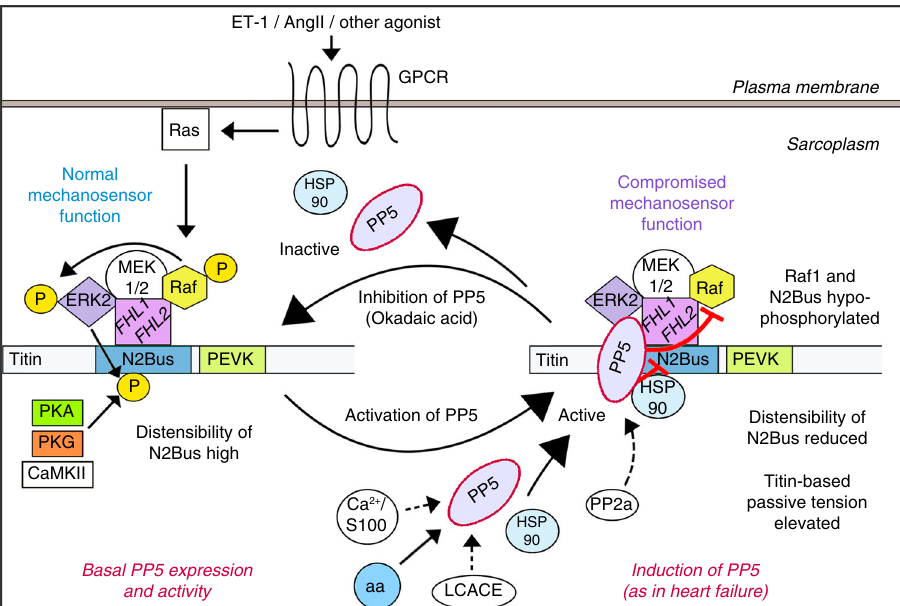
Fig. 8 Proposed actions of PP5 in cardiomyocytes. Under basal conditions, PP5 activity towards titin N2Bus and MAPK/ERK family member Raf1 is low and the relatively high distensibility of N2Bus results in relatively low titin-based passive tension (left side). The strain-dependent mechanosensor connecting MAPKs to N2Bus via FHL-1 functions normally, as downstream signaling from Raf1 to ERK2 is enabled. When PP5 expression is increased (as in failing hearts) and PP5 becomes activated through interaction with Hsp90, Ca 2+ /S100 protein, arachidonic acid (aa), or long chain fatty acid-CoA esters (LCACE), the phosphatase translocates to the I-band mechanosensor at N2Bus (right side). Thus, N2Bus (previously phosphorylated by ERK2, PKA, PKG, or CaMKII) is dephosphorylated, which reduces its distensibility and increases titin-based passive tension; the mechanosensor is now less sensitive. Raf-1 is also dephosphorylated and signaling to ERK2 is disabled, such that the mechanosensor function is additionally compromised. The process is embedded in signaling pathways activated via G-protein coupled receptor (GPCR) and Ras, and it can be reversed when PP5 is deactivated. (Molecules that have a color code were studied here, those with no color/white background were inferred from the